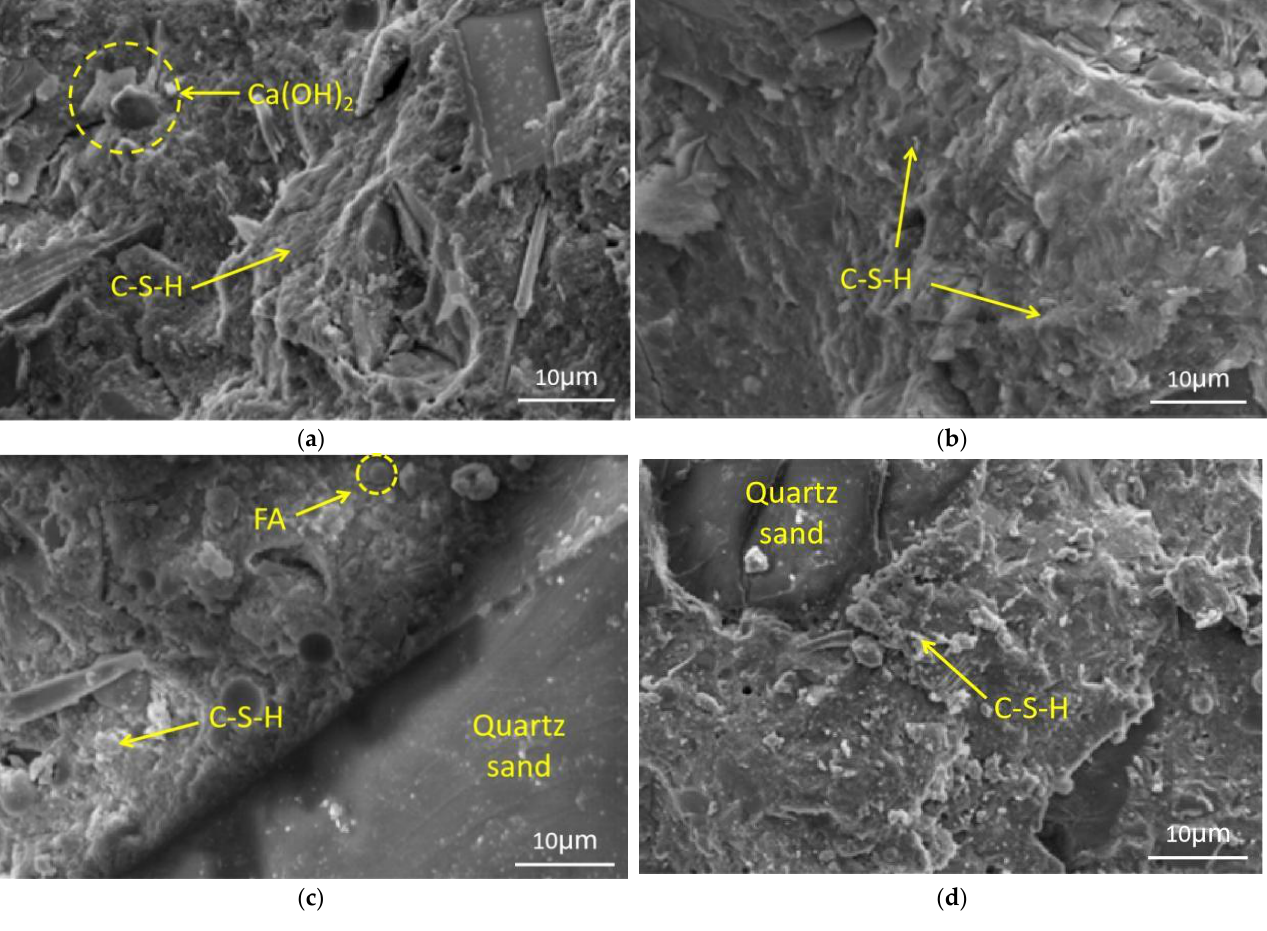
Figure 7. SEM images of EUHPC under different curing regimes: ( a ) S20F0G0 under standard curing; ( b ) S20F0G0 under steam curing; ( c ) S20F10G10 under standard curing; ( d ) S20F10G10 under steam curing.